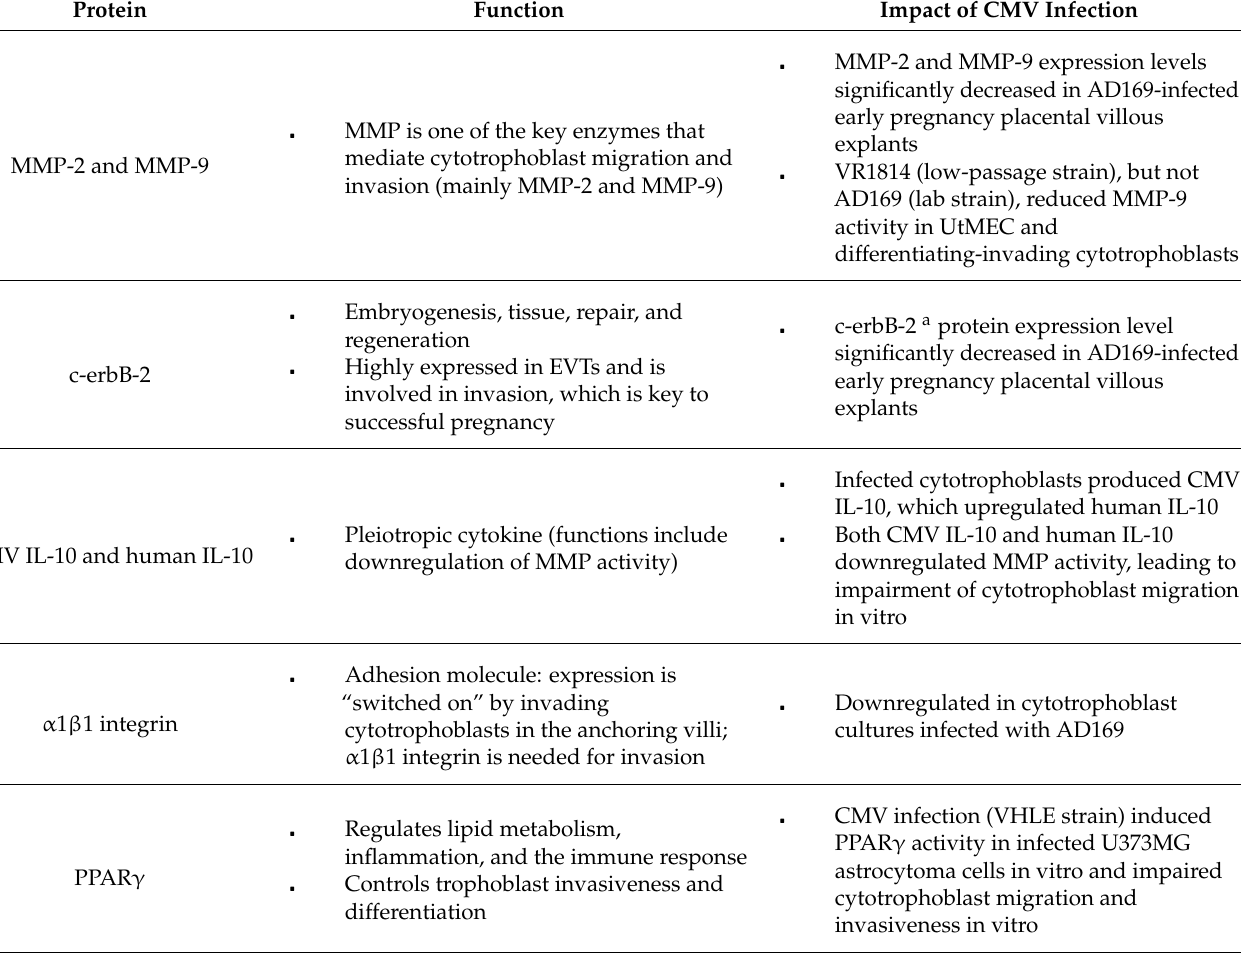
Table 4. Cytomegalovirus infection: altered expression of molecules involved in cytotrophoblast differentiation and